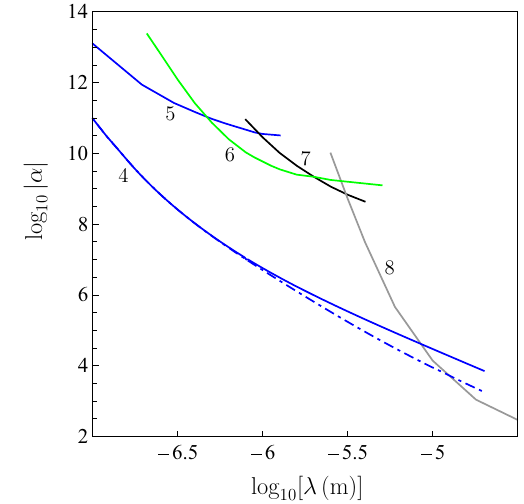
Fig. 2 Constraints on the parameters of Yukawa-type corrections to Newton’s gravitationallawobtainedintherecent[21]andprevious [36] isoelectronic experiments ( lines 4 and 5 , respectively), from measuring the difference of lateral forces [37] ( line 6 ), from the torsion pendulum experiment [38] ( line 7 ), and from the Cavendish-type experiments [39, 40] ( line 8 ). The dashed-dotted line shows the prospective constraints obtained in this work (see the textfor further discussion). The regions of the plane below each line are allowed and above each line are